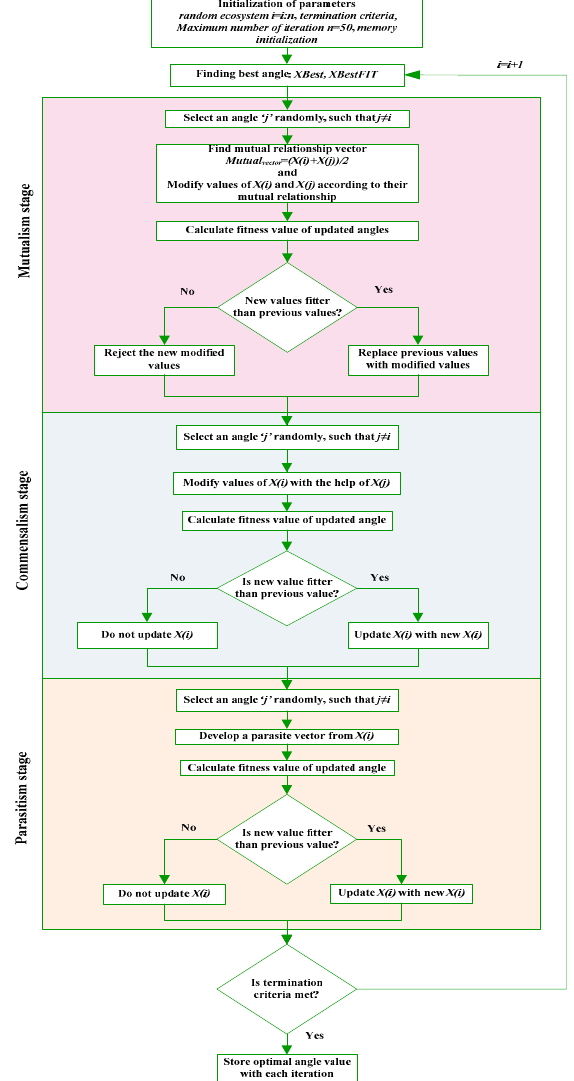
Figure 4. Block diagram of the SOS algorithm applied to the SHE problem.